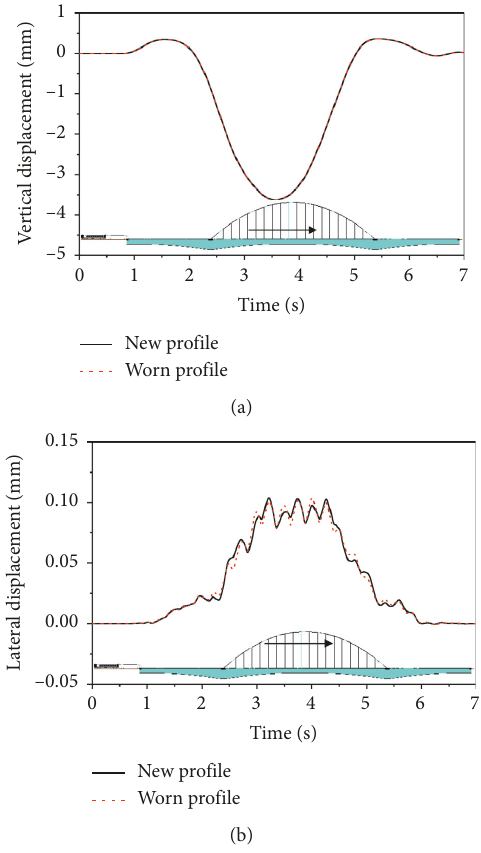
Figure 20: Time histories of displacement at the midsection of the main span (speed: v � 350km/h): (a) vertical; (b)